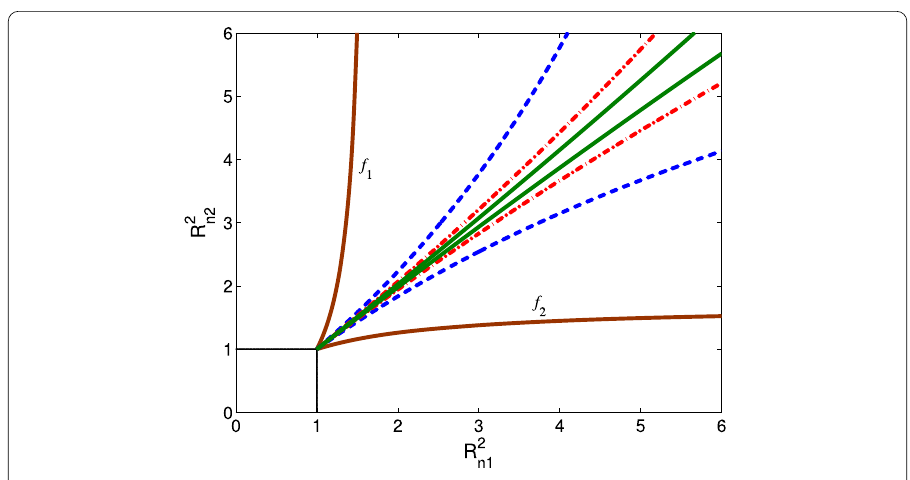
Figure 6 Showing the region of secondary infection covered by the functions f 1 and f 2 given in (4.4) with λ = 0.0714 (brown solid), 0.0110 (blue dashed), 0.0037 (red dashdot), and 0.0014 (green